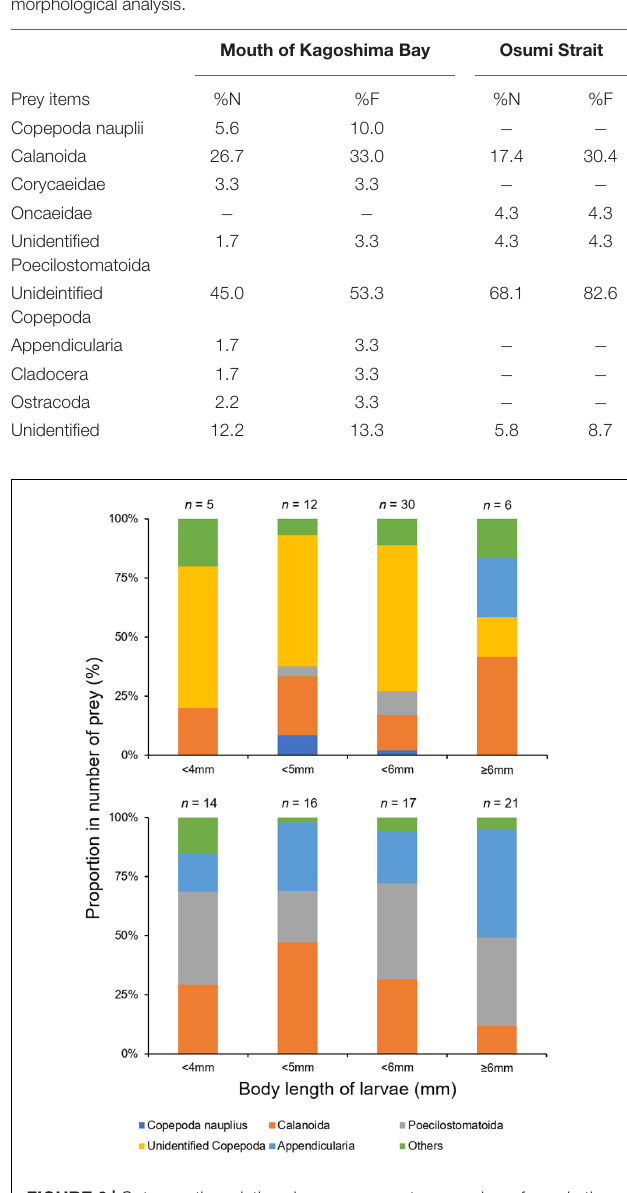
FIGURE 6 | Ontogenetic variations in mean percentage number of prey in the diet of Scomber japonicus larvae, based on both morphological (top) and DNA metabarcoding (bottom) analyses. Numbers indicate sample